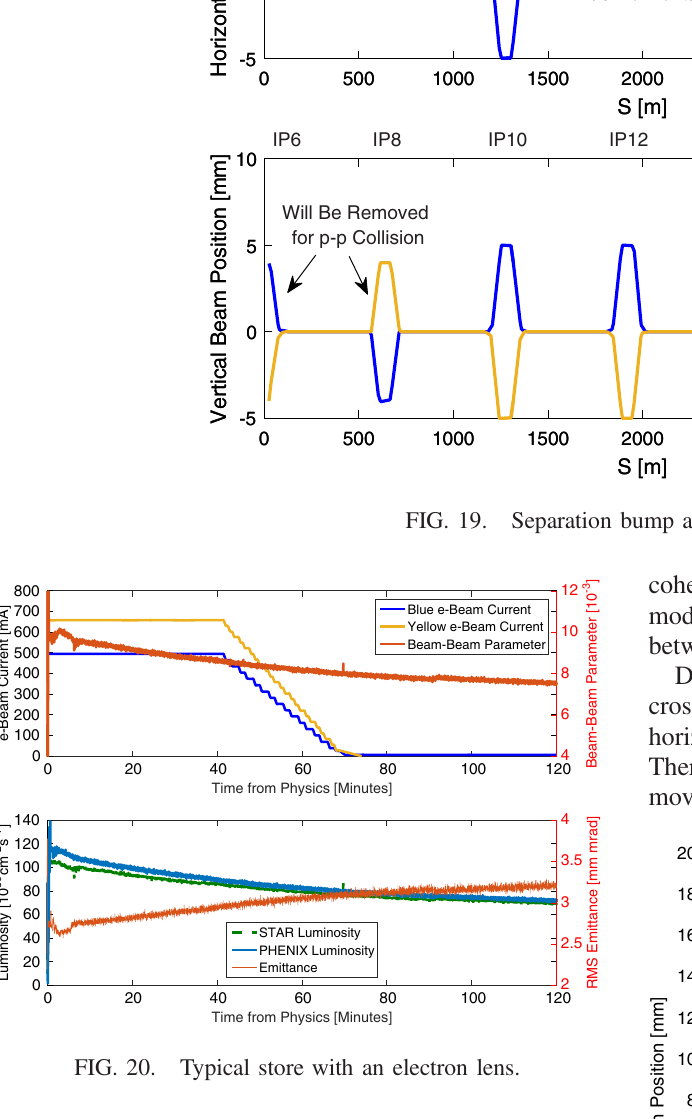
FIG. 20. Typical store with an electron lens.